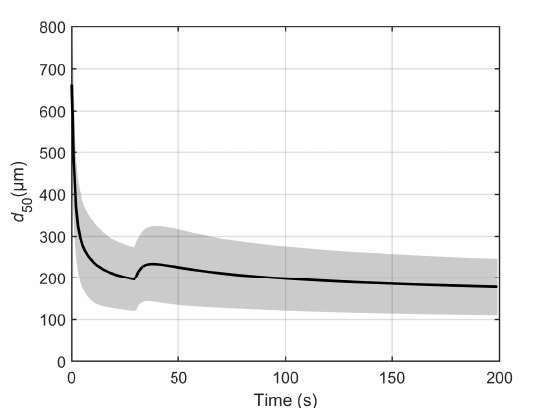
Figure 8. Model prediction (black solid) with 95% confidence range (shaded) using second-order polynomial chaos.